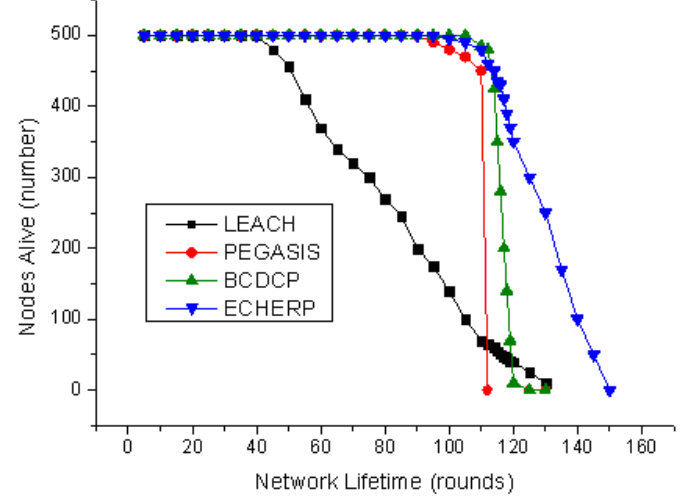
Figure 5. Number of nodes alive versus the network lifetime in